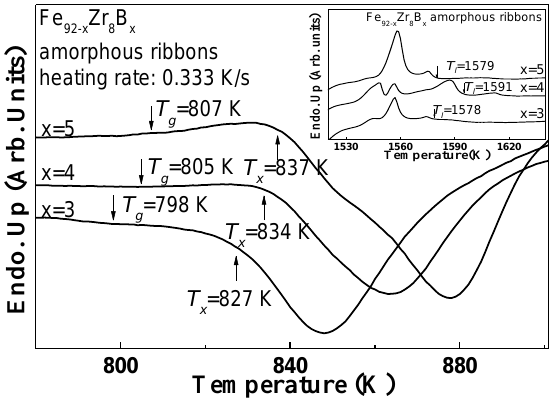
Figure 2. Di ff erential scanning calorimetry (DSC) traces of the Fe 92 − x Zr 8 B x (x = 3, 4, 5) alloys with the heating curves obtained at 20 K / min; the inset is the melt DSC trace.